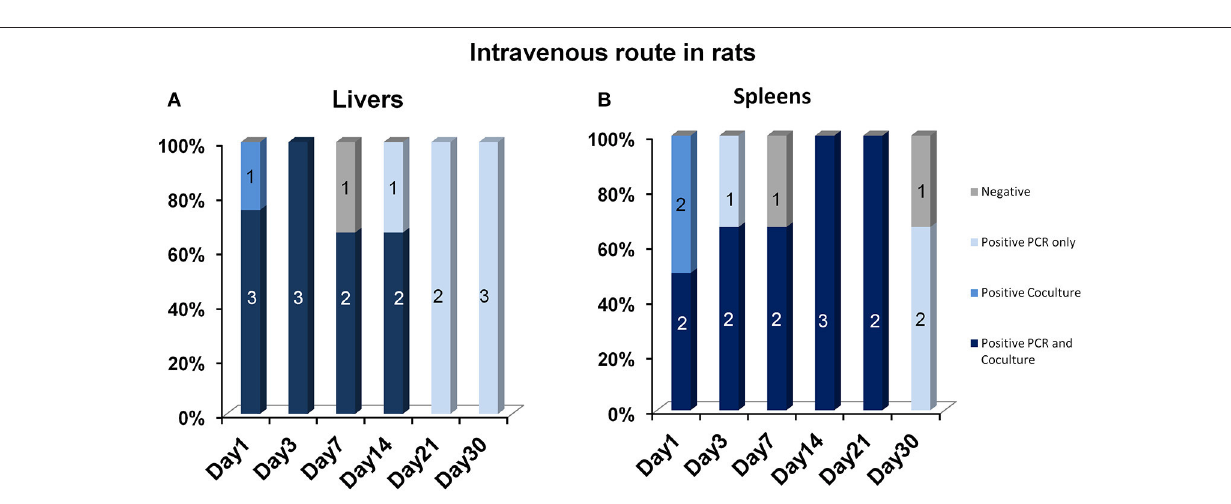
viable Marseillevirus was detected as much as 3 weeks later in the spleen. In the aerosolized model, the virus was detected at a higher frequency in NALT than in lung samples, especially at later time points. Interestingly, the DNA viral load at day 30 PI was 4.7 log units of viral copies per million of murine cells, in other words, not that different to the load just after aerosolization (5.9 log units of viral copies per million of murine cells). Conversely, in the lungs, the viral load regularly decreased until it was undetectable at day 30 PI. Although our results do not show a viral replication, the long persistence into the NALT of aerosol inoculated mice is congruent with the human case of Marseillevirus persistence in pharyngeal samples (Aherfi et al.,